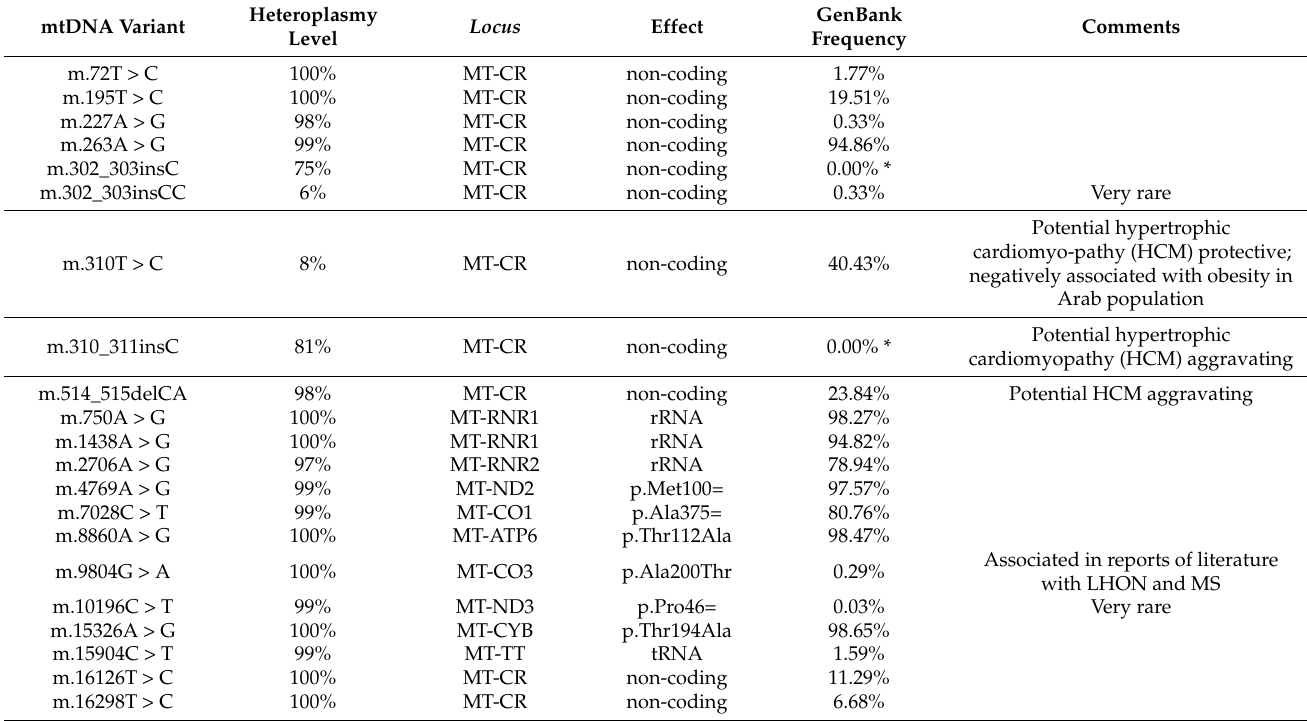
Table 9. Mitochondrial variants and their heteroplasmy identified in the athlete by next generation sequencing